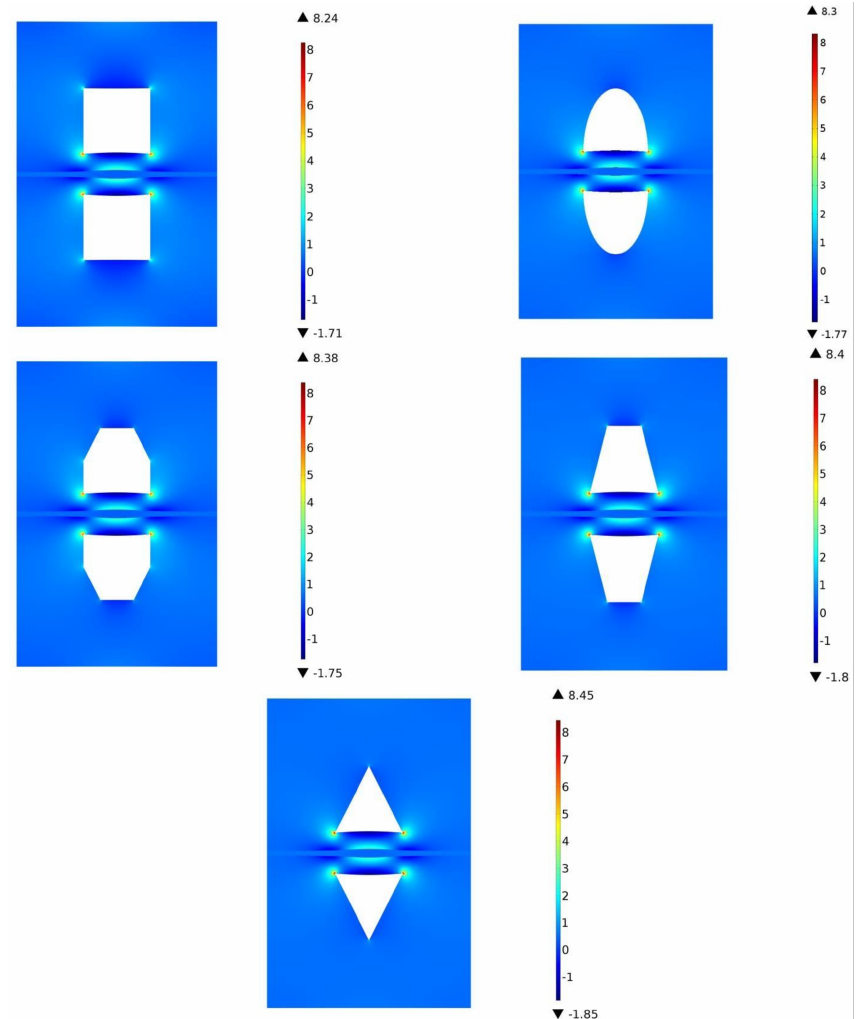
Figure 8. Pressure variations (MPa) in the PEM-FC through the process of assembly at height = 1 mm, with scale increased 50